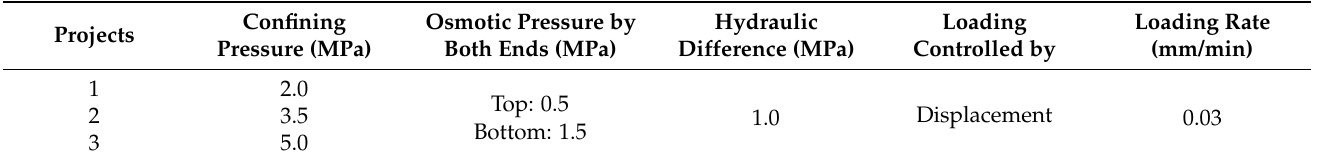
Table 1. Parameters of the permeability